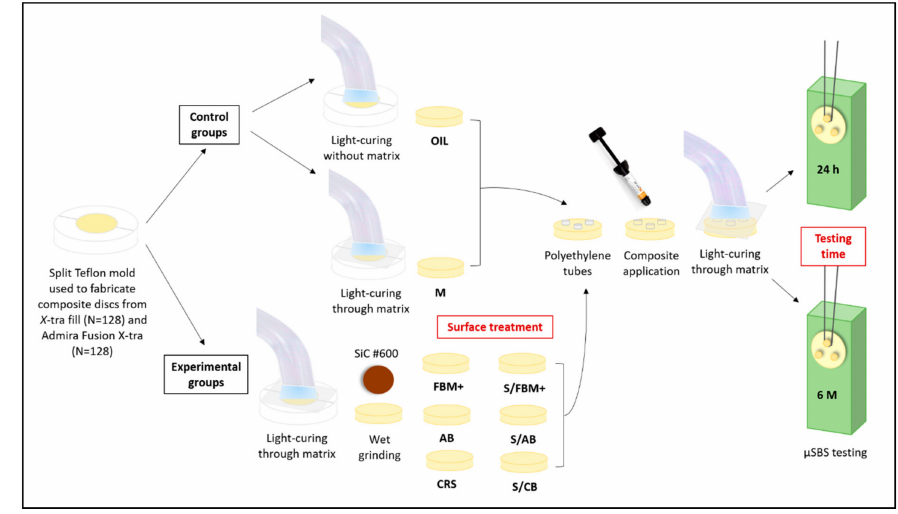
Figure 1. Specimen preparation and repair